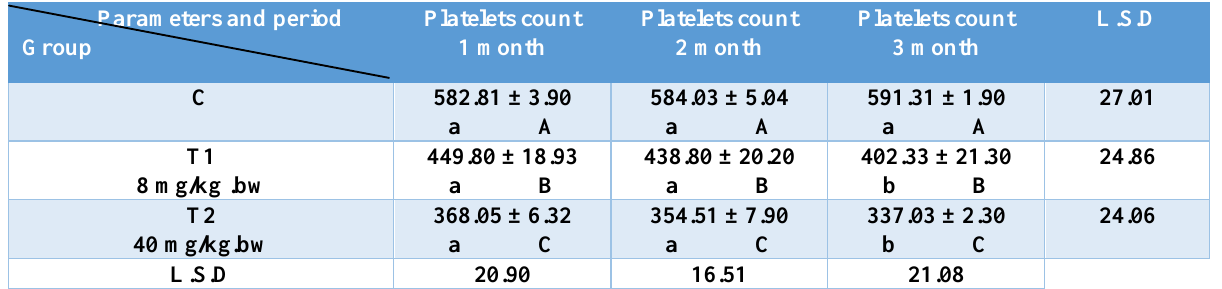
Table, 7: Values of Platelets count ( cells*10³/cm³) in blood of rats treated with different doses of CuSO4.5H2O